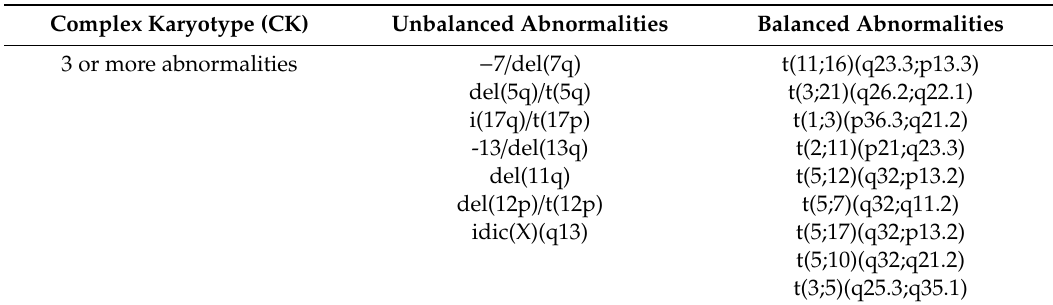
Table 1. Per WHO classification, cytogenetic abnormalities su ffi cient to diagnose acute myeloid leukemia (AML) with myelodysplasia-related changes when ≥ 20% peripheral blood or bone marrow blasts are present and prior therapy has been excluded